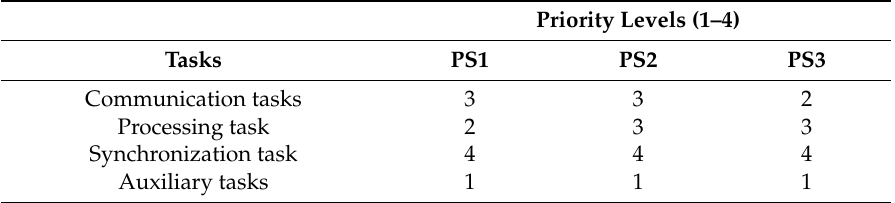
Table 3. Priority levels of N1 node tasks for the different priority